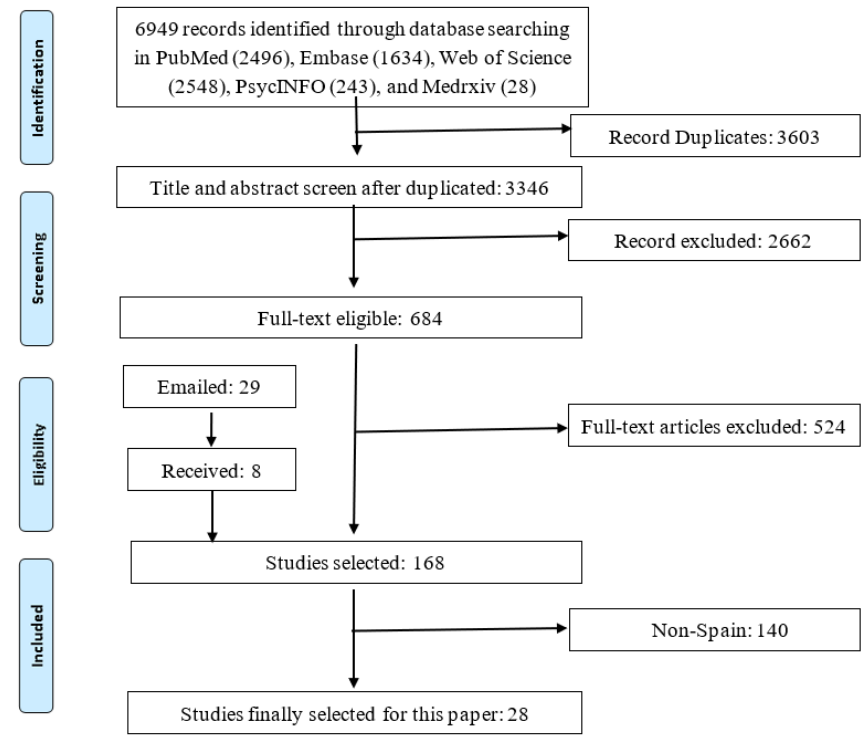
Figure 1. A PRISMA flow diagram.